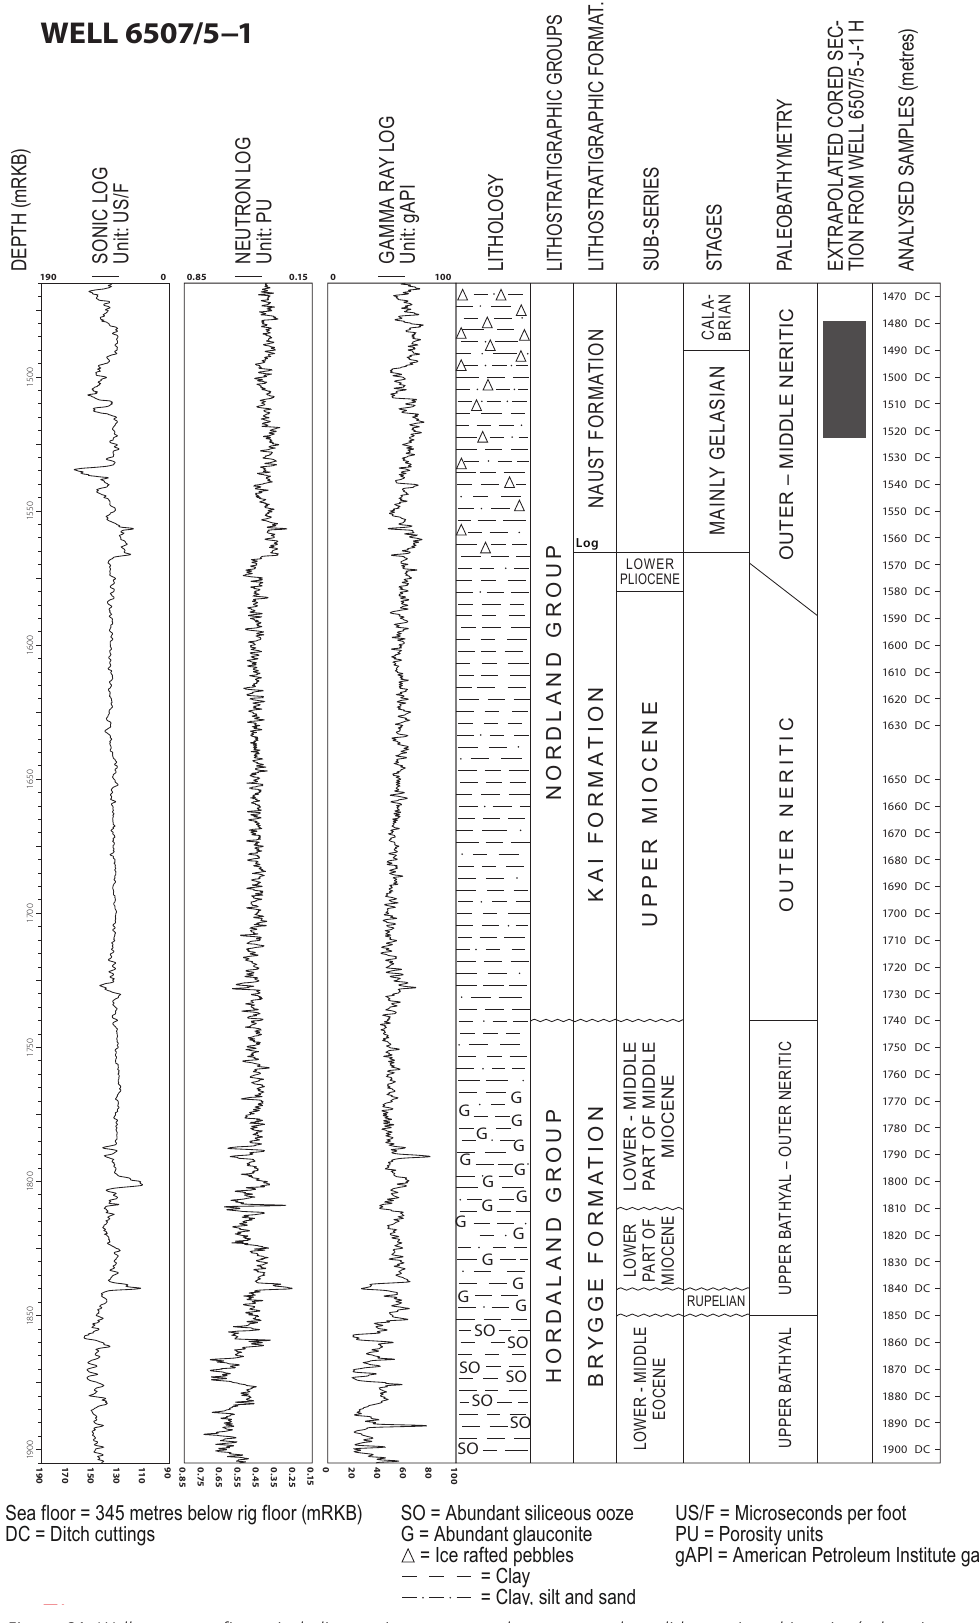
= Clay = Clay, silt and sand Fig. 64 Figure 64. Well summary figure including sonic, neutron and gamma-ray logs, lithostratigraphic units (sub-series, stages) paleobathymetry and analysed samples for the investigated succession in well 6507/5–1 (lower–middle Eocene to Calabrian) including the new supplementary well reference sections for the Kai and Naust